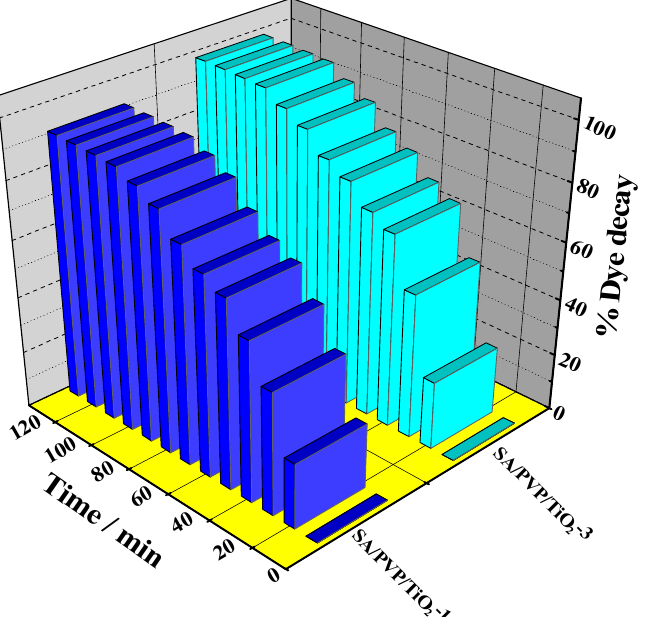
Figure 5. Effect of the illumination time in the degradation of methylene blue (%) in light using the SA/PVP/TiO 2 nanocomposites beads.